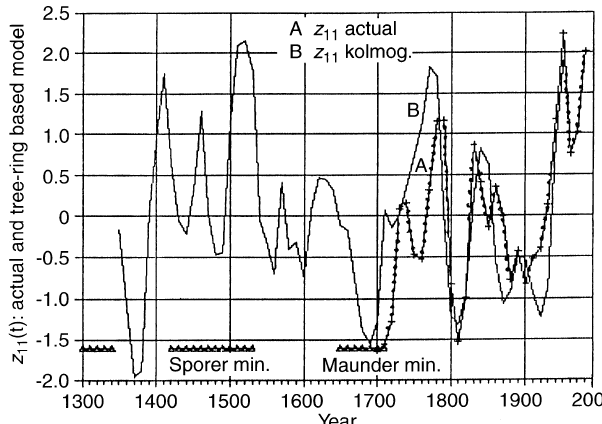
Fig. 23. Tree-rings and past